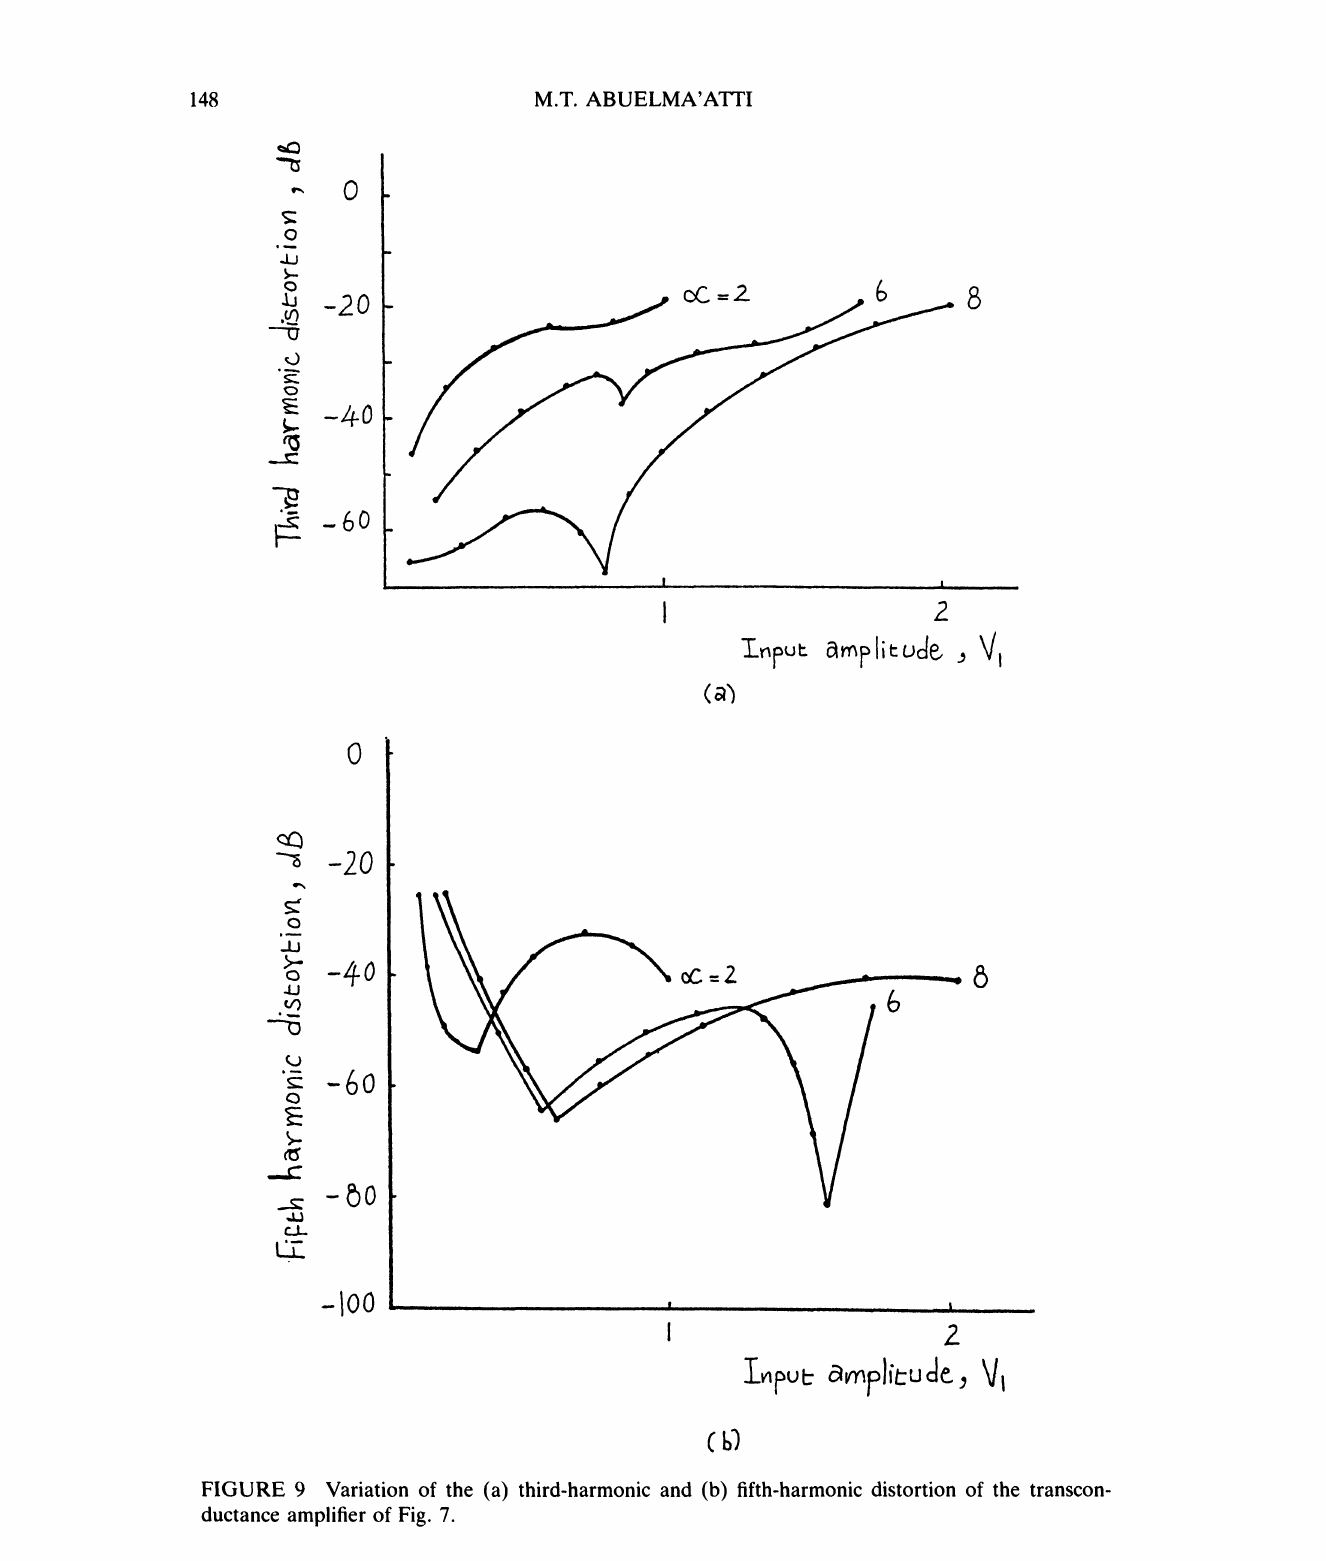
FIGURE 9 Variation of the (a) third-harmonic and (b) fifth-harmonic distortion of the transcon- ductance amplifier of Fig.